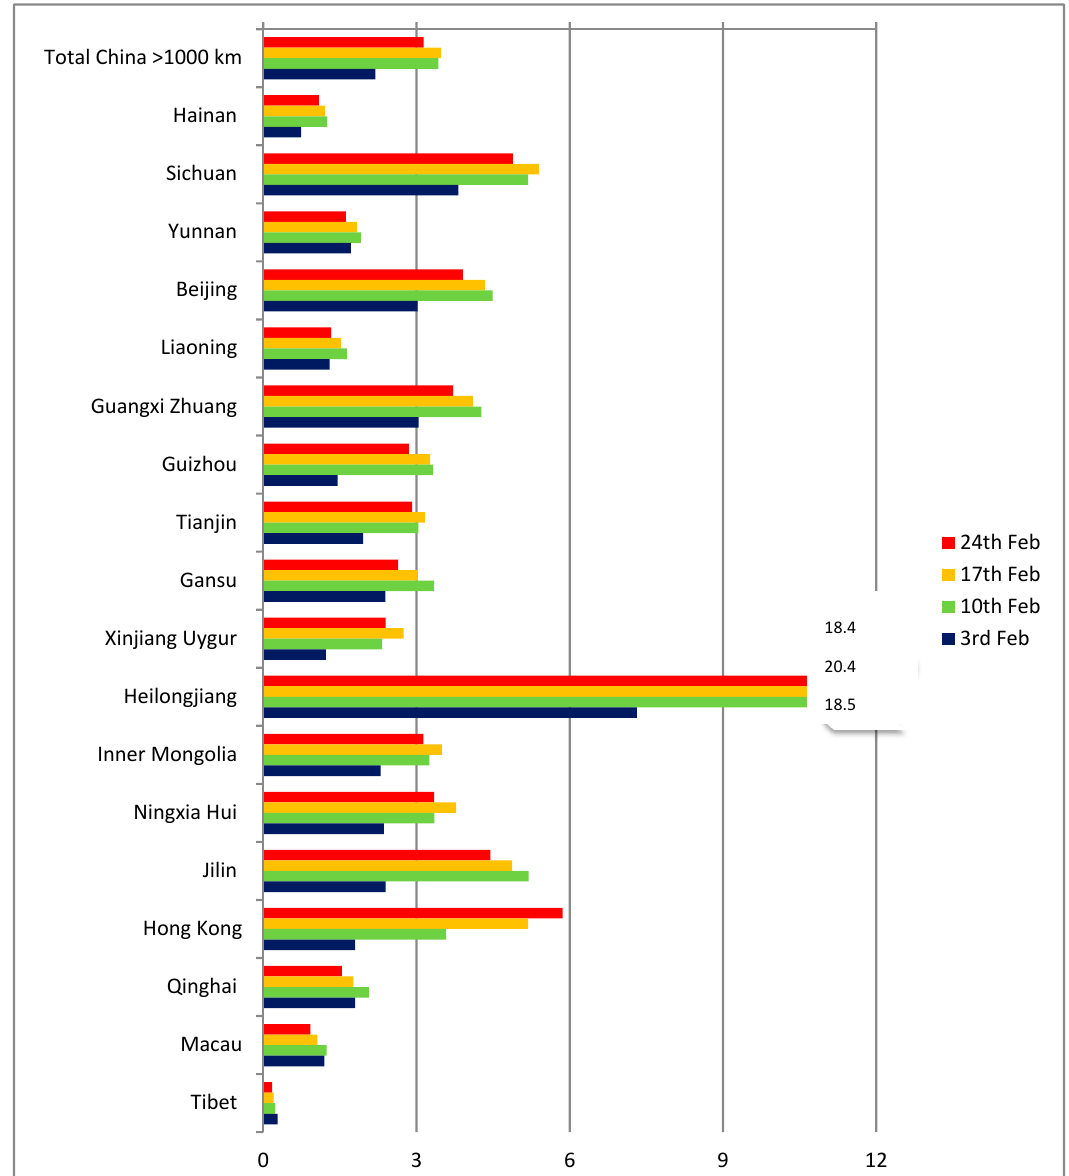
Figure 4. Estimated ratio of infected passengers, (cases per 1000 passengers), China (over 1000 km from Wuhan).